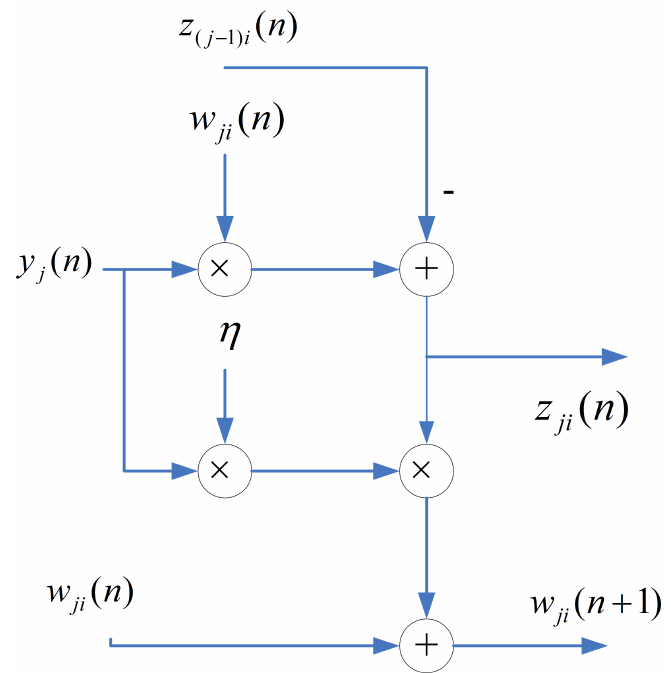
Figure 4. The architecture of each module in the SWU